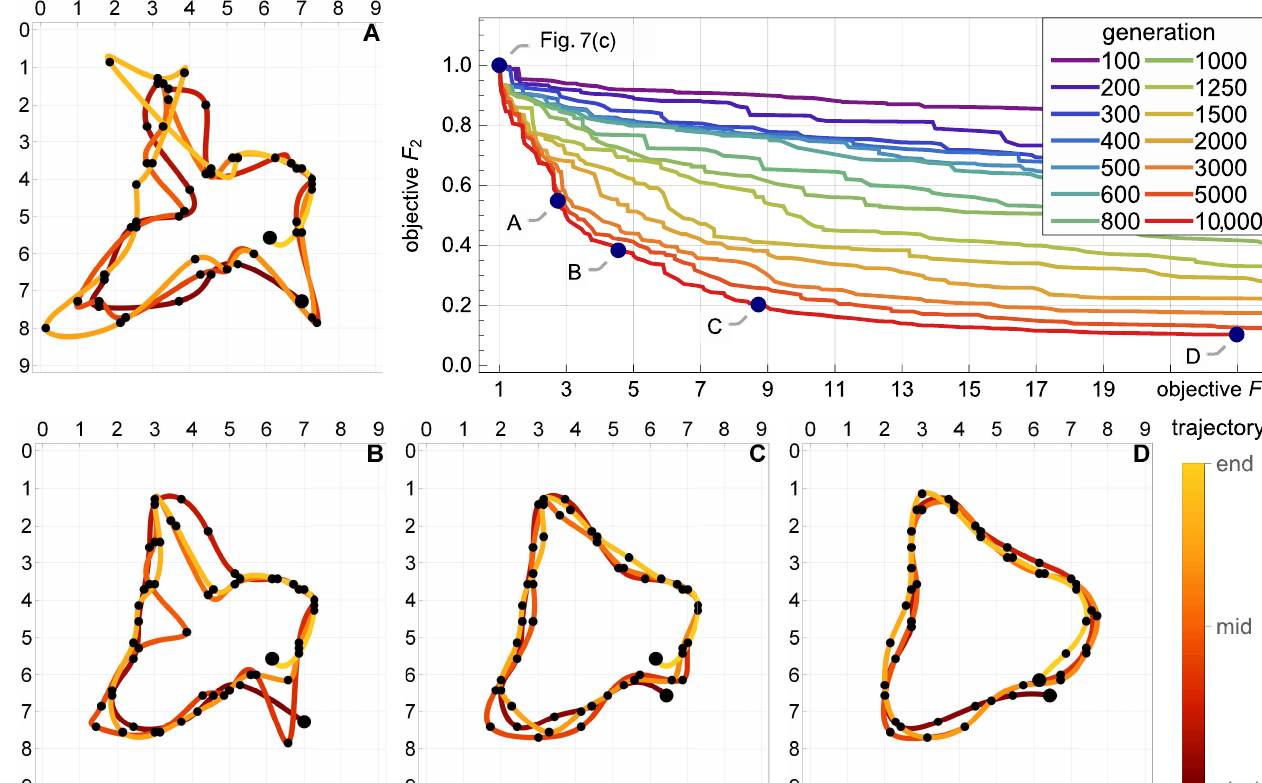
Figure 10. Multicriterial identification of the triangle trajectory: advancement of the Pareto front and four specific trajectories along the final front (A, B, C and D). The top left dot on the Pareto front corresponds to the trivial F 1 -optimum trajectory shown in Figure 7c. The actual trajectory is shown in Figure 2.